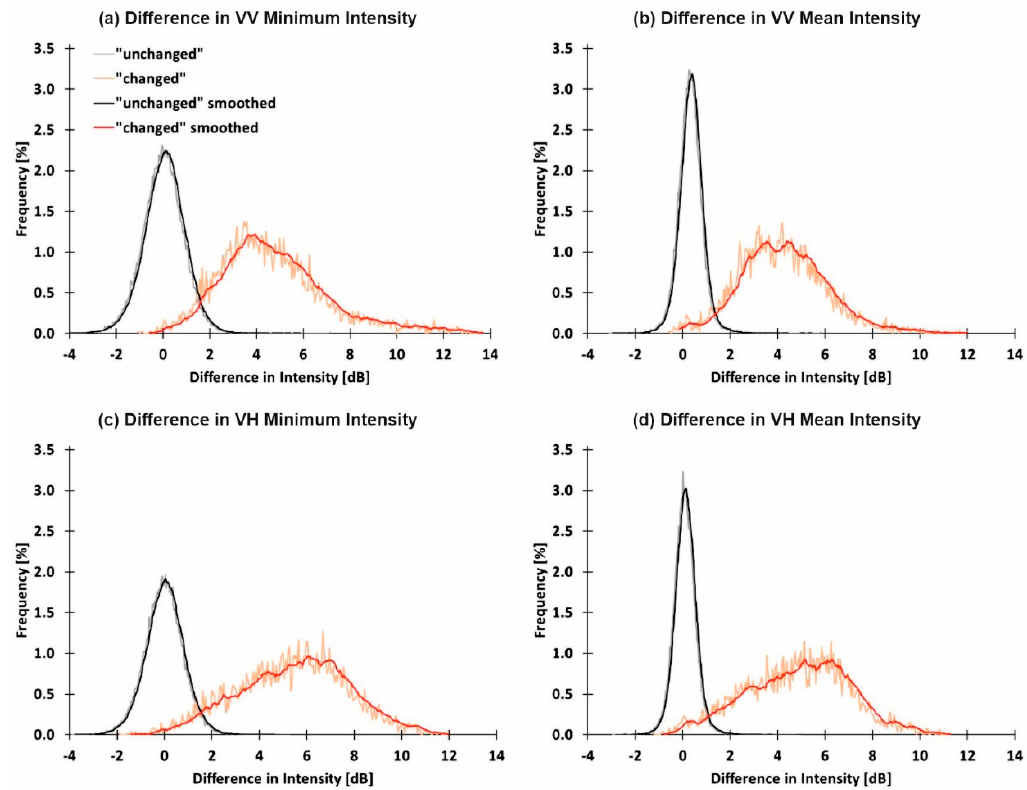
Figure 6. Frequency distributions of the classes “unchanged” (gray/black) and “changed” (orange/red) for the VV/VH intensity differences between the two temporal subsets “2015/2016” and “2016/2017”. Results are shown for the time series features minimum (MIN) ( a , c ) and mean (MEAN) ( b , d ). Information on “unchanged” and “changed” samples were taken from Google Earth Imagery (see Section 2.3 and Figure 3). Smoothing of the histograms was done by averaging the frequencies of five consecutive bins.